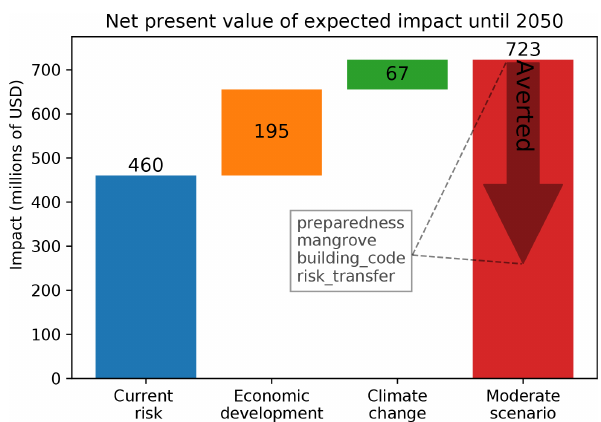
Figure 3. Net present values (NPVs) of the expected tropical cy- clone damage (average annual impact, AAI) in Anguilla by 2050. “Current risk” represents the NPV of the expected impacts from 2016 until 2050 if neither assets nor climate changes are taken into account. “Moderate scenario” shows the NPV of expected impacts with moderate economic development and climate change follow- ing RCP 4.5. The separate contribution to the total expected impact are shown in the “Economic development” and “Climate change” columns, respectively. The “Averted” arrow shows the quantity of impact that can be averted combining the preparedness, man- grove, building_code, and risk_transfer measures, as explained be- low (Fig.